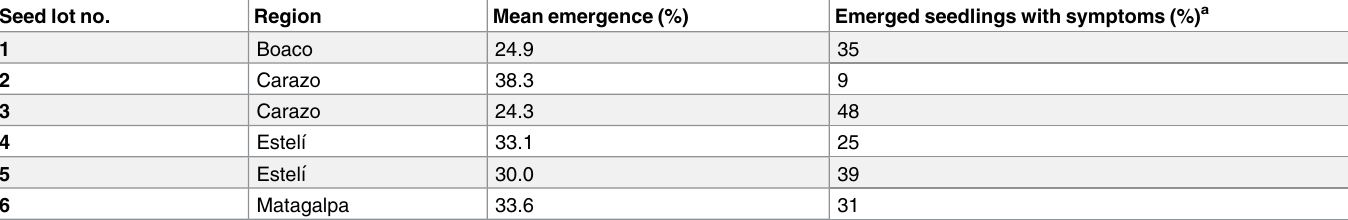
a Percentage of the emerged seedlings that showed disease symptoms, including cankers, stem or root lesions, necrosis, and/or